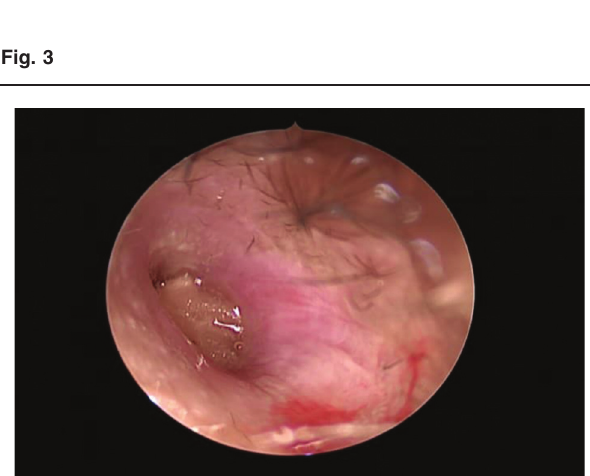
The fat graft being placed in the perforation.